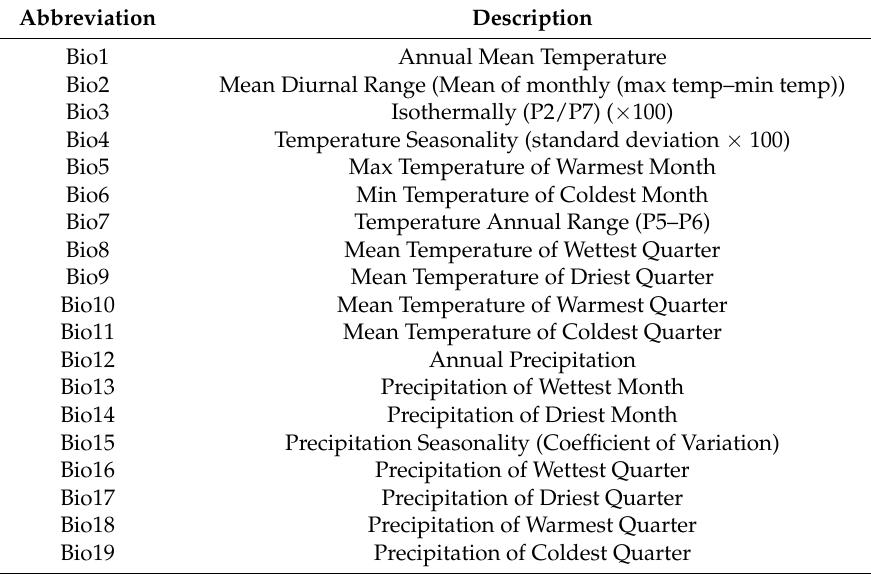
Table 1. Predictor variables used in the construction of the niche